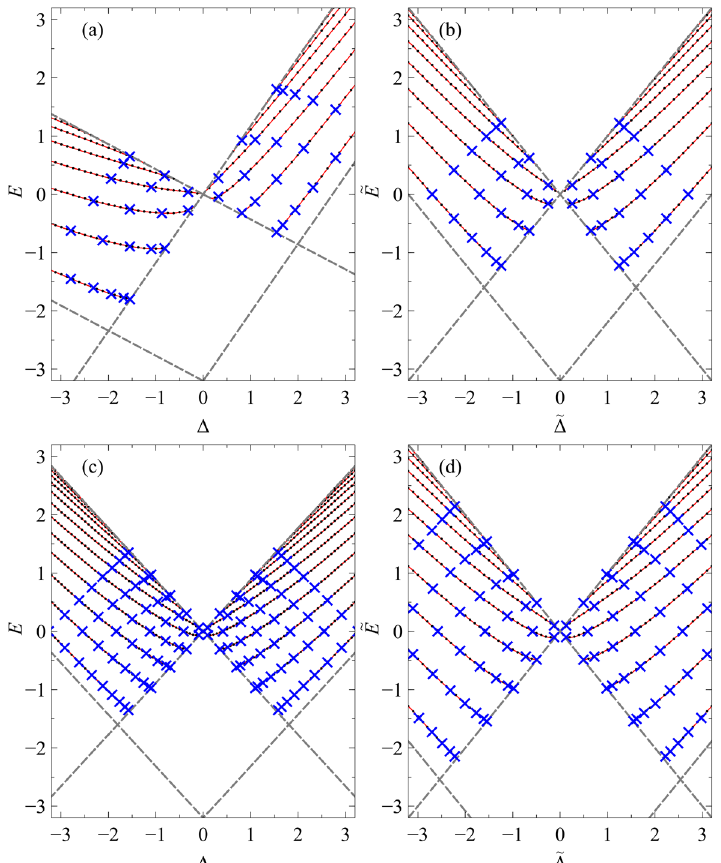
1 chirality, i.e., the K valley in the effective = 3.2 , as a function V 0 / cosh ( x ′ / L ) , of strength V 0 = = − 0 and ( c ) θ π/ 2 in L , for the orientations ( a ) θ k ′ y = = = 0.86 v F , v 0.32 v F . The energy spectra of 0.69 v F and v t = y = =